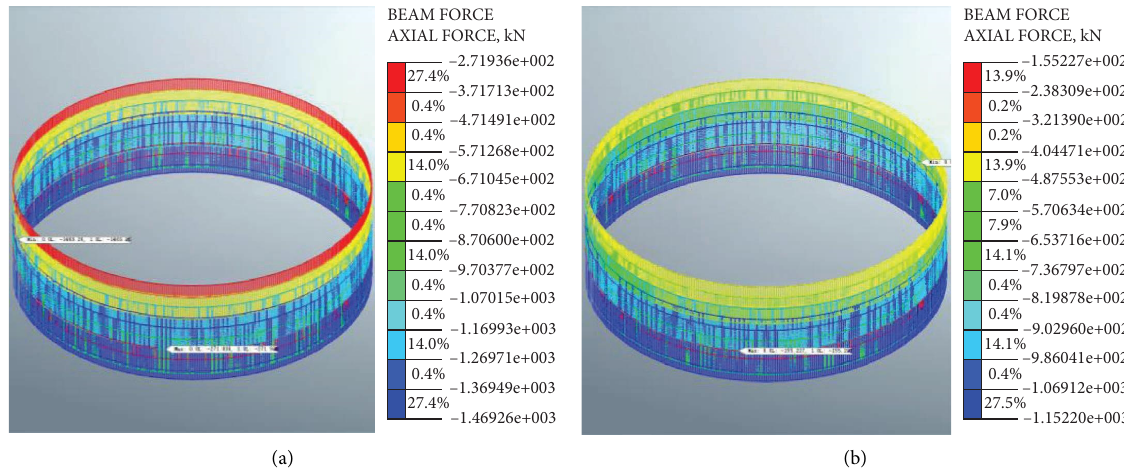
Figure 35: Working condition 8 lining axial force (a) without pore water pressure and (b) with pore water pressure